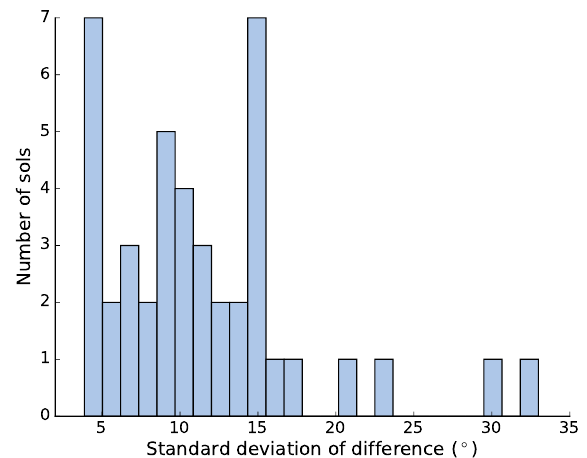
Figure 23. Standard deviation of the angle difference during sols 1–45.